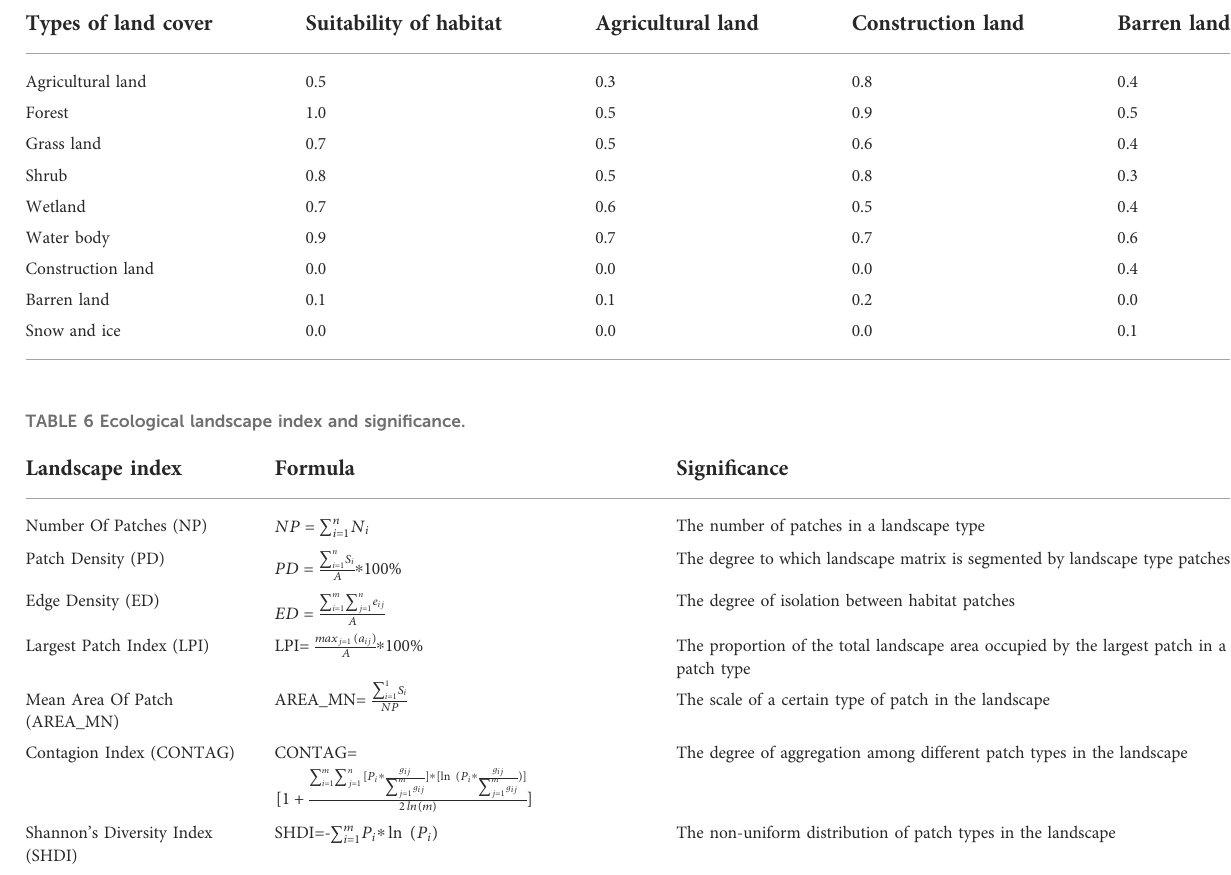
TABLE 5 Sensitivity of land-use types to habitat stress factors.